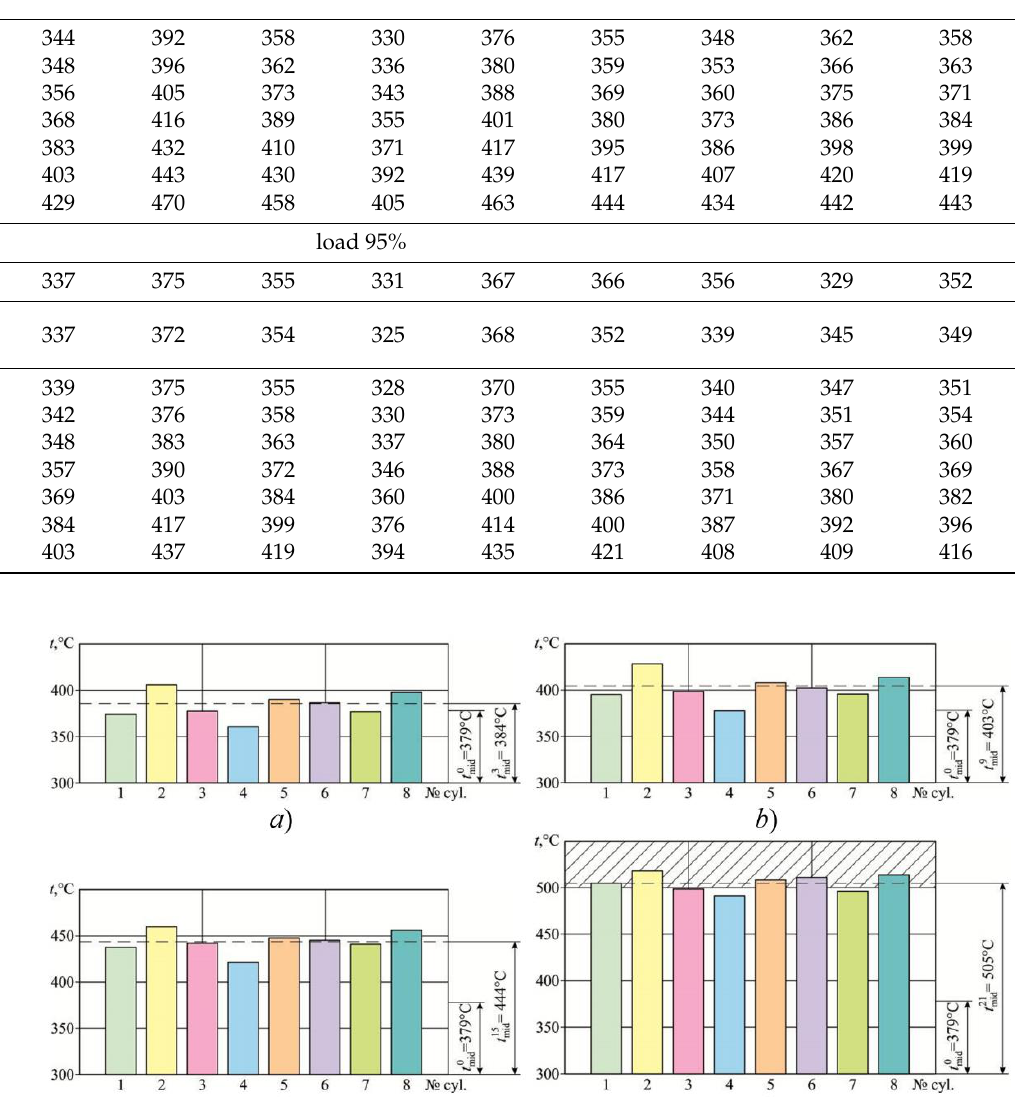
Figure 12. Change in exhaust gas temperature in the cylinders of a 16V32 STX-MAN marine diesel engine at different values of the degree of exhaust gas recirculation (load 55%): ( а ) δ EGR = 3%; ( b ) δ EGR = 9%; ( c ) δ EGR = 15%; ( d ) δ EGR = 21%.